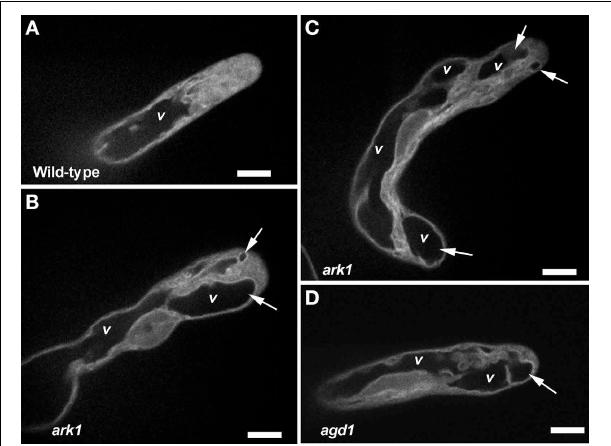
FIGURE 7 | Simplified and speculative model for ARK1- and AGD1- mediated control of root hair tip growth. The various domains of AGD1 and ARK1 proteins are shown. Bin1-Amphiphysin-Rvs167p/Rvs161p (BAR), Pleckstrin Homology (PH), GAP, and Ankyrin repeat (ANK) for AGD1 (Vernoud et al., 2003) and kinesin MOTOR and armadillo repeat-containing (ARM) domains for ARK1 (Yang et al., 2007). In this model, RHD4, PI4K β 1, and PIP5K3 influence AGD1 activity by their timely depletion and synthesis of PI monophosphates (e.g., PI-4P; Preuss et al., 2006; Kusano et al., 2008; Stenzel et al., 2008; Thole et al., 2008). COW1 is involved in the transfer of PIs (dashed arrow; Phillips et al., 2006) to facilitate binding to PH domain of AGD1 (Yoo et al., 2012) or possible interaction with ARK1. PI binding to AGD1 would in turn modify the activity of a yet to be determined ARF-GTPase. Because ARF-GTPase has been shown to control ROP2 targeting (Xu and Scheres, 2005), AGD1 could influence F-actin organization indirectly and as a result mediate RabA4B and vacuolar dynamics (Preuss et al., 2004; Yoo et al., 2008, 2012). AGD1 and ARK1 could act in parallel pathways where ARK1 mediates crosstalk between microtubules (via the kinesin motor domain) and F-actin (via the ARM domain) (Yang et al., 2007). Although genetic interaction studies presented here implicate PIs in the ARK1 function, possibly through COW1 (dashed arrow), the precise mechanisms by which this is accomplished is